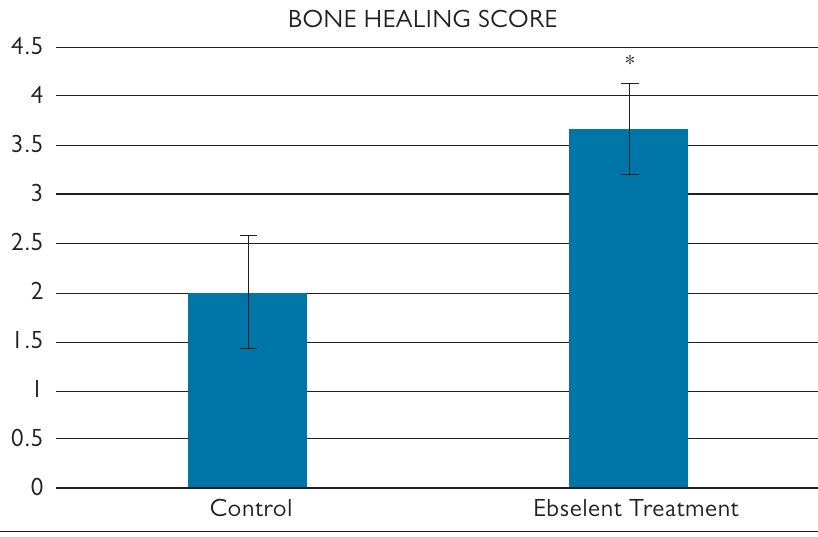
Figure 3. X-ray control scores in ebselen treatment group.